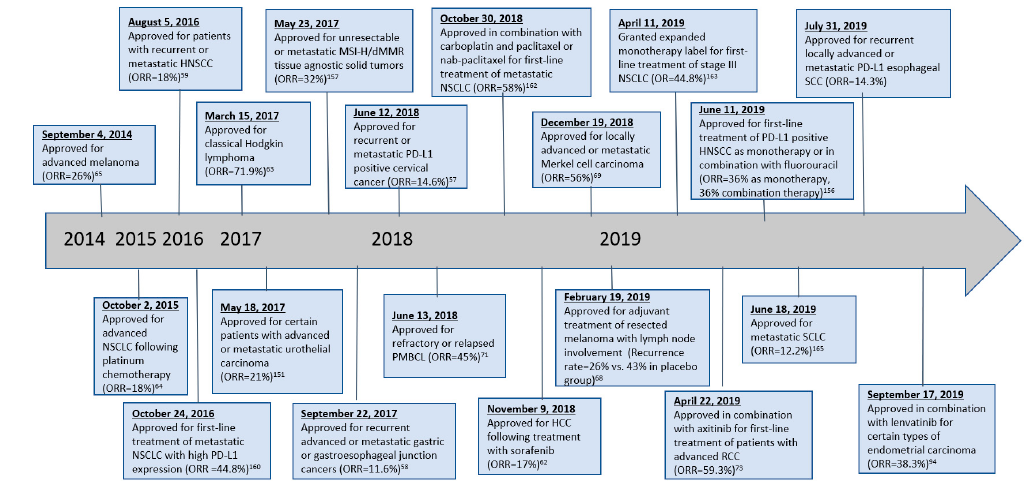
Figure 4. Timeline of pembrolizumab FDA approvals.